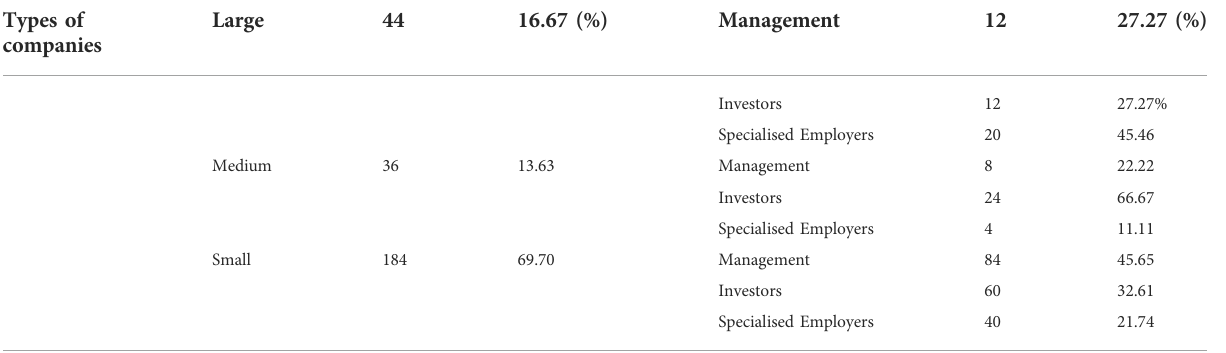
TABLE 1 The structure of the sample and of the type of the respondents. Types of